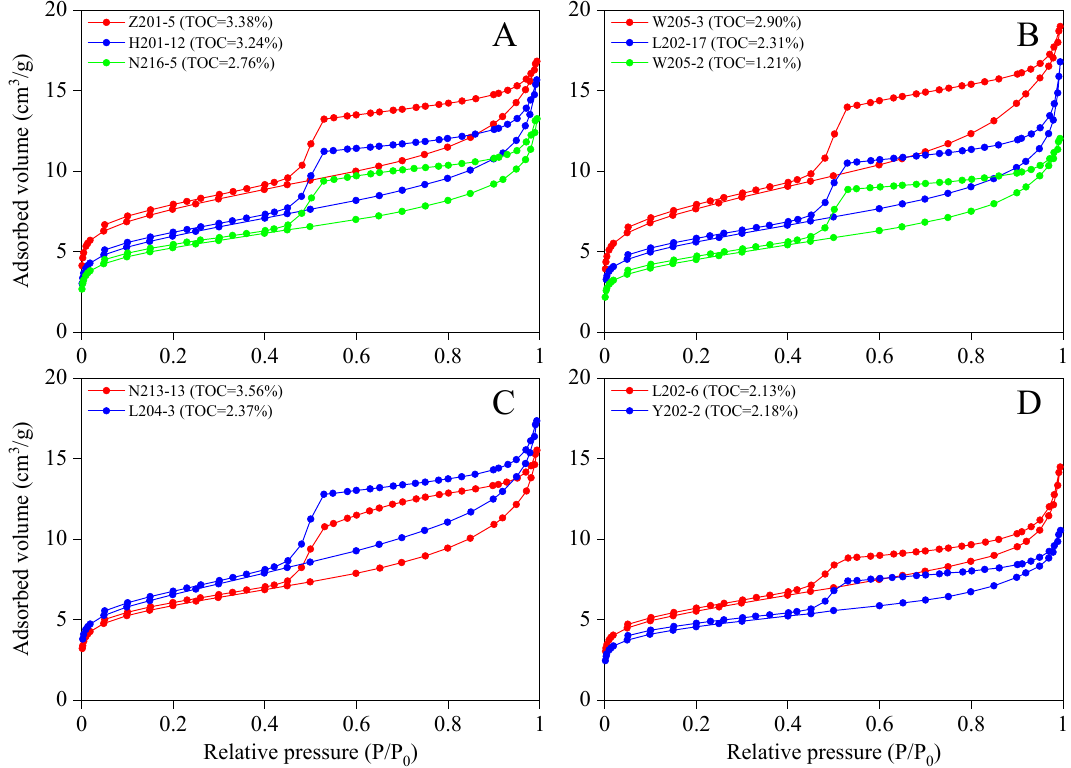
Figure 9. The N 2 adsorption and desorption isotherms of Longmaxi shales. (A) wide mouth hysteresis loops, 2.5% < TOC < 3.5%, (B) wide mouth hysteresis loops, 1% < TOC <3%, (C) wide mouth hysteresis loops, 2% < TOC < 4%, (D) flat hysteresis loop, 2% < TOC <2.5%.